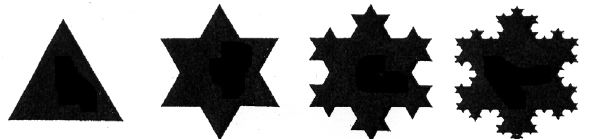
Figuur 4: Die Koch-sneeuvlokkie (die eerste vier ordes). (Aangepas uit Keidel, 1995, p.